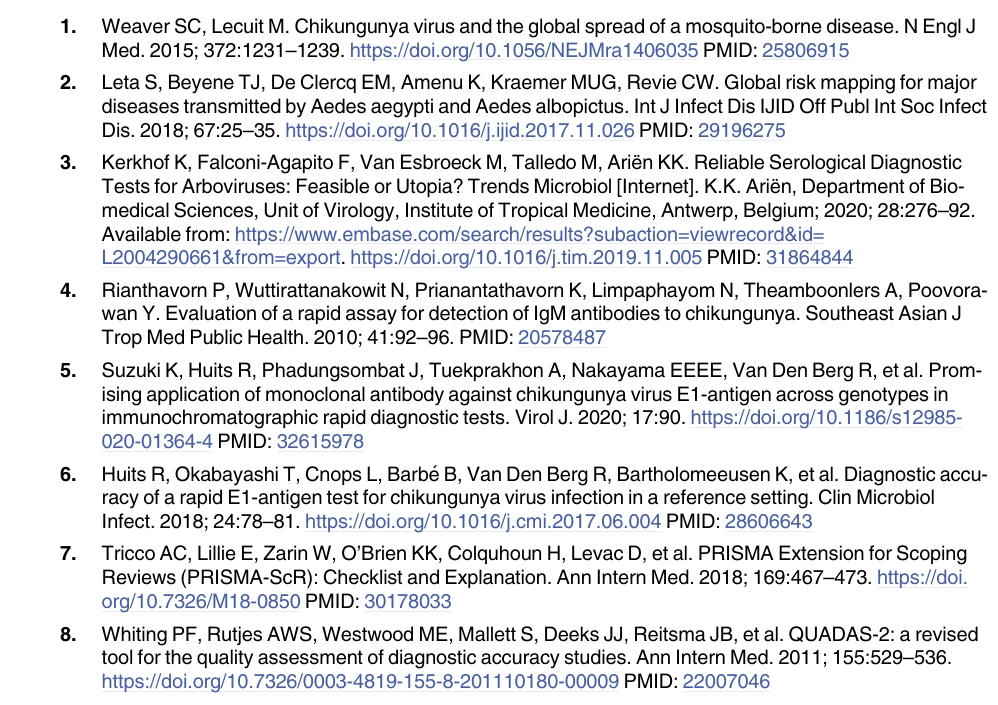
S2 Fig. Global Chikungunya rapid diagnostic tests landscape—key players on industry, 2005–2018. S3 Fig. Number of samples tested according to Chikungunya rapid diagnostic test, 2005– 2018. S1 Table. Characteristics of commercial Chikungunya rapid diagnostic tests for point-of- care application registered by the Brazilian National Health Surveillance